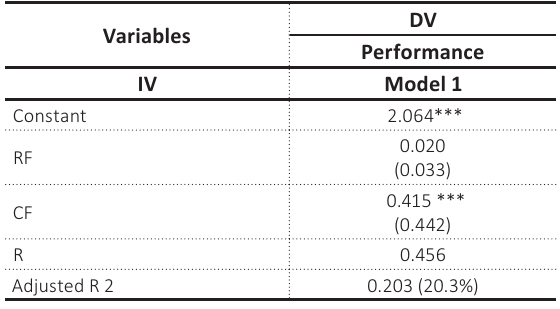
Table 3. Regression results of different